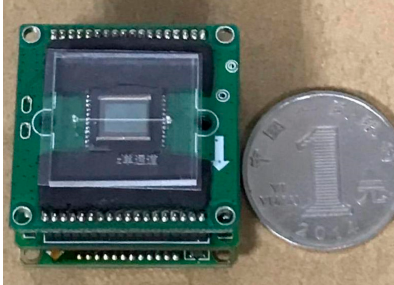
Figure 11. Comparison between the microfluidic chip and a renminbi (RMB) coin.